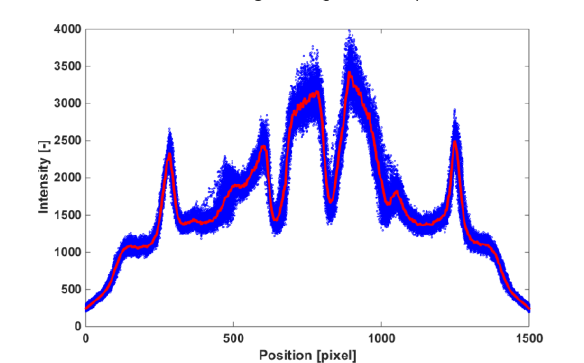
Fig. 10. C 10880-03, 25% gain, exp. time 20µs, cross-section